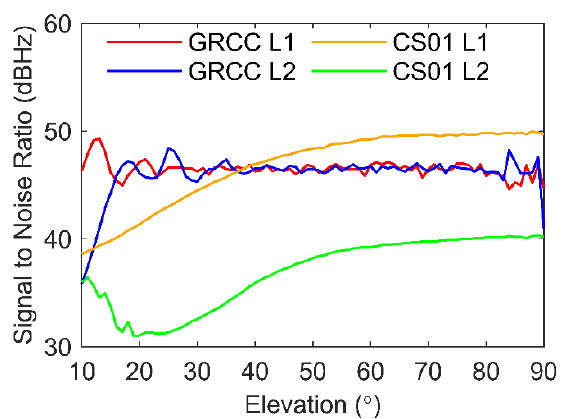
Figure 3. Signal to noise ratio series with elevation for GRCC and CS01.